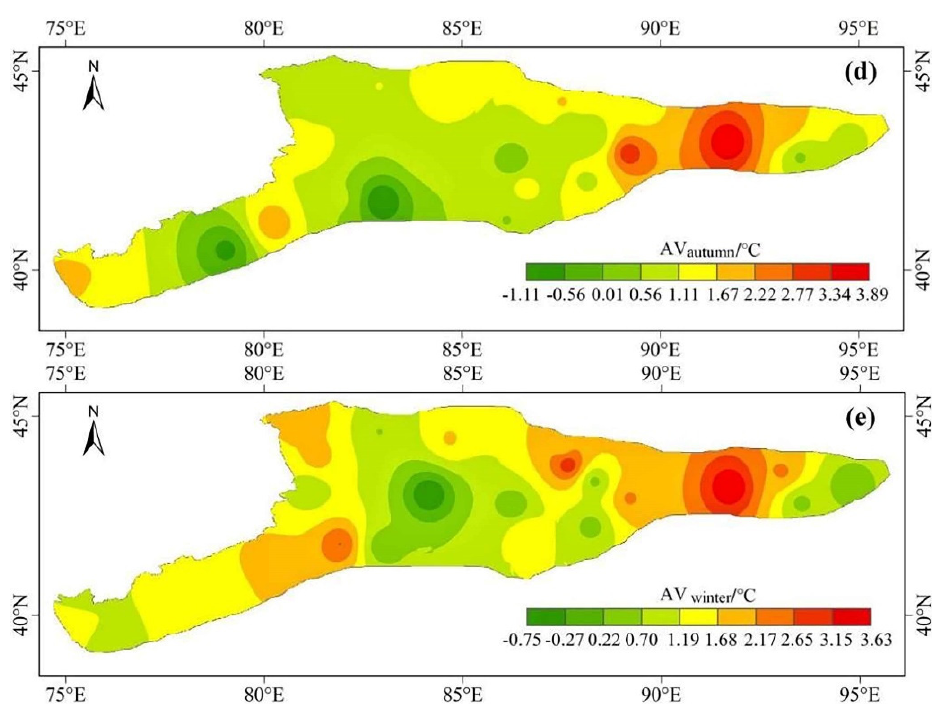
Figure 5. ( a ) Spatial distribution of AAV, ( b ) AVspring, ( c ) AVsummer, ( d ) AVautumn, and ( e ) AVwinter within the CTMR.